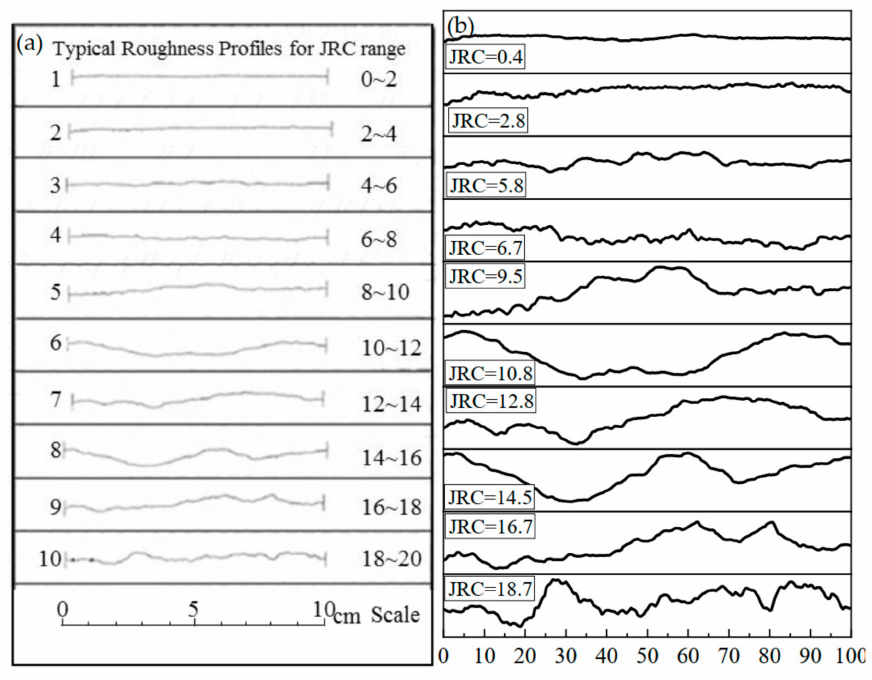
Figure 2. Standard JRC profile ( a ) Before reconstruction, ( b ) After reconstruction.